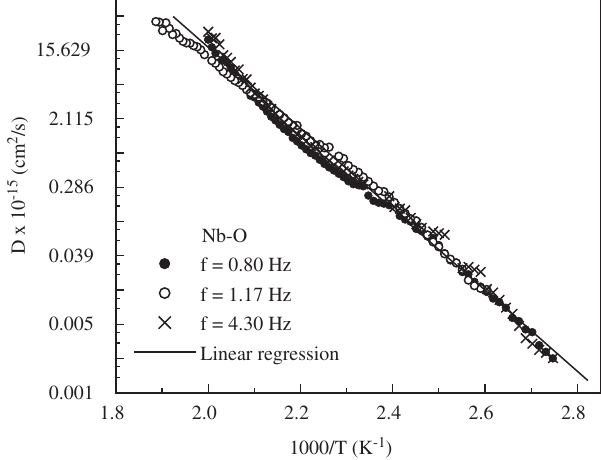
Figure 8. Internal friction as a function of temperature for Nb sample measured with frequency of 0.80 Hz. The full line shows Debye’s